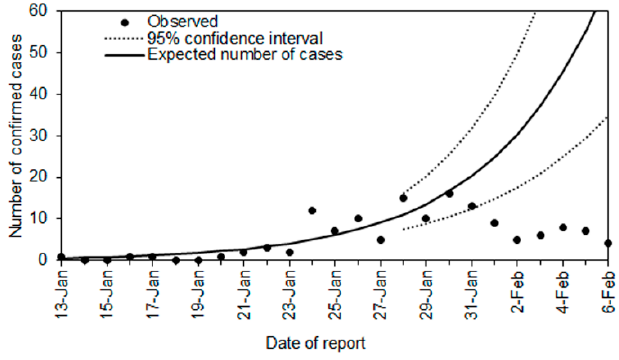
Figure 2. Observed and expected number of cases diagnosed outside China by date of report. Observed cases (dots) include those infected in China. An exponential growth curve was fitted to the observed data from 27 January 2020. The dashed lines represent the 95% confidence interval on and after